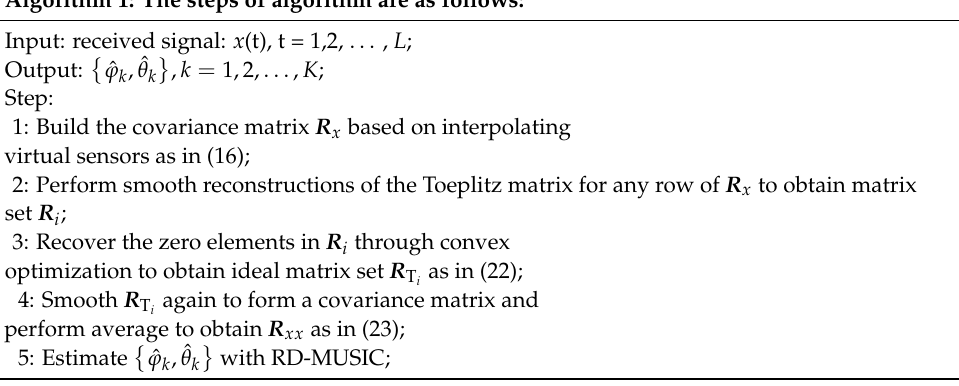
Algorithm 1: The steps of algorithm are as